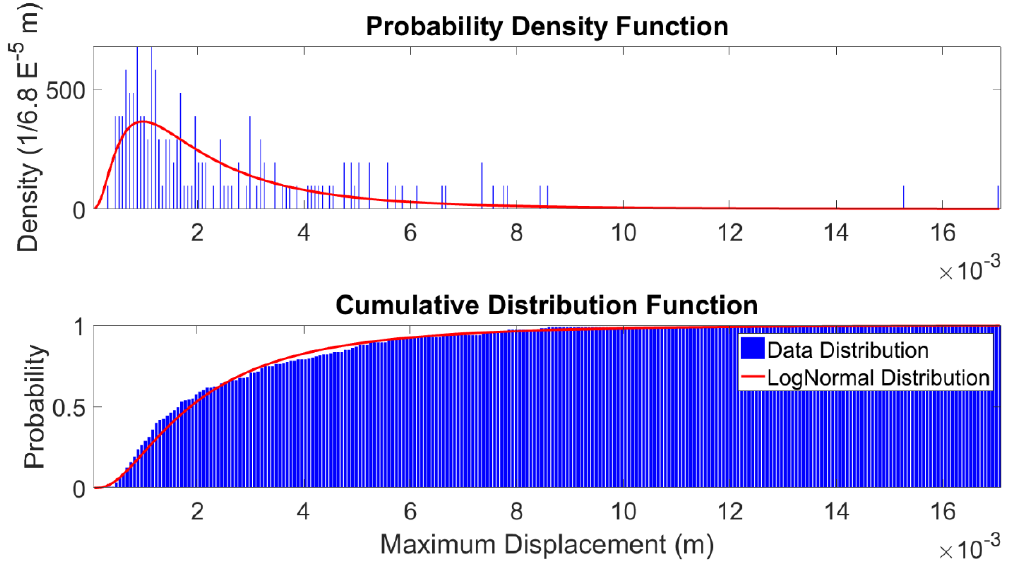
Figure 12. Maximum displacement demands based on Northridge Earthquake records.